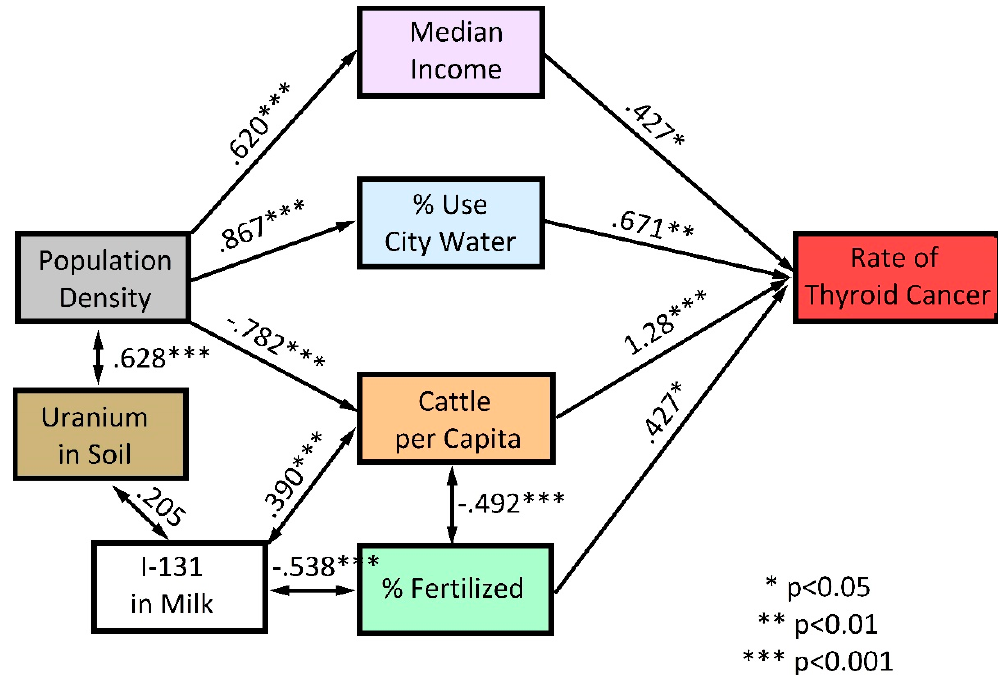
Figure 2. Structural Equation Model for county-specific thyroid cancer incidence rates in North Dakota. Uni-directional arrows indicate potential causal pathways. Bi-directional arrows indicate a co-varying relationship that is unlikely to be causal.